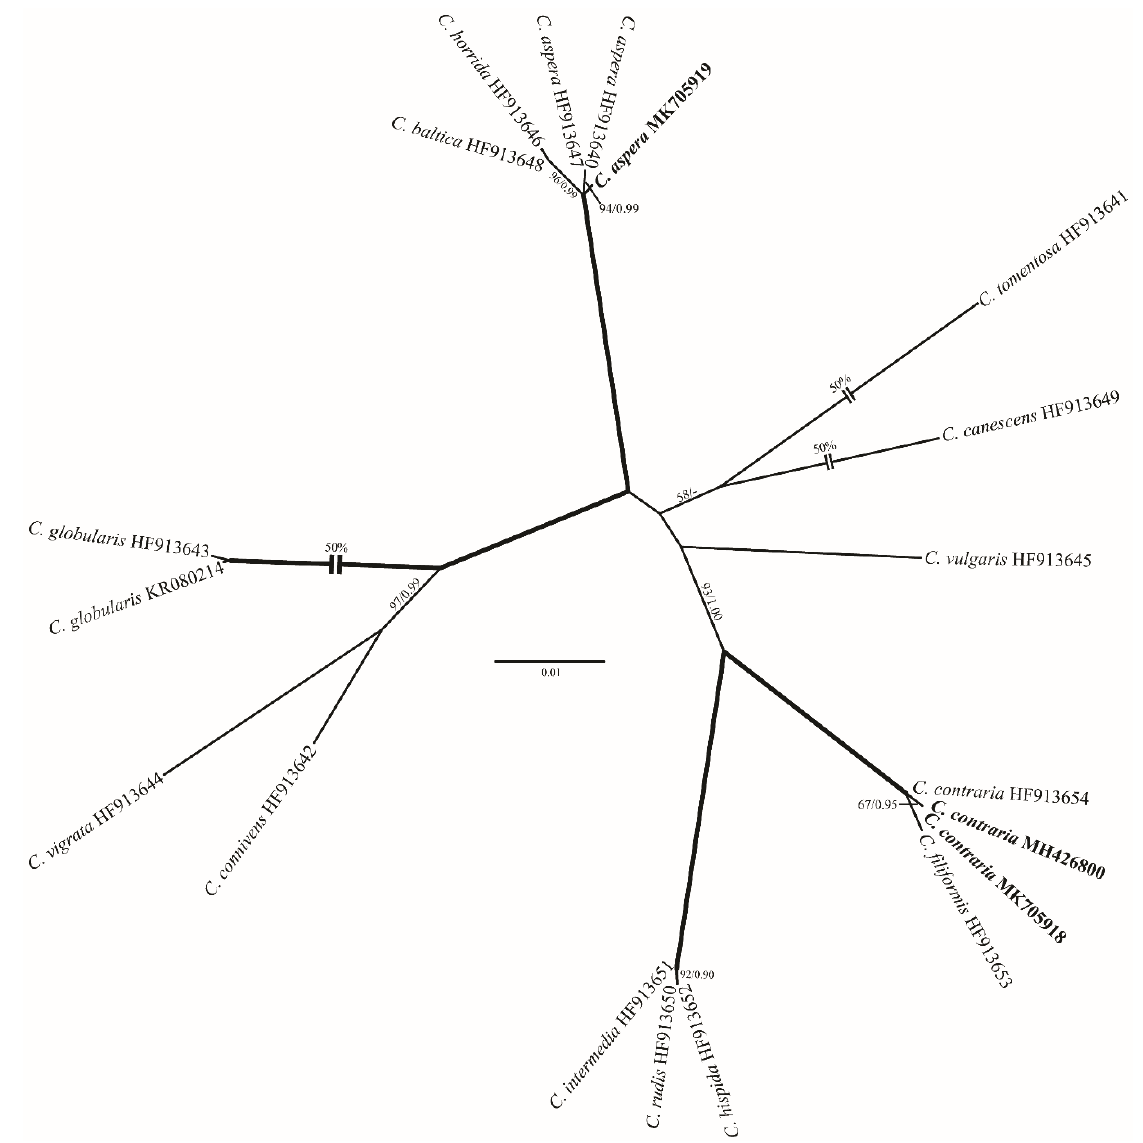
Figure 4 . Phylogeny of Chara (19 accessions) based on ITS rDNA sequence comparisons. The tree was inferred in PAUP with HKY+G nucleotide substitution model. See the legend of Figure 1 for details.